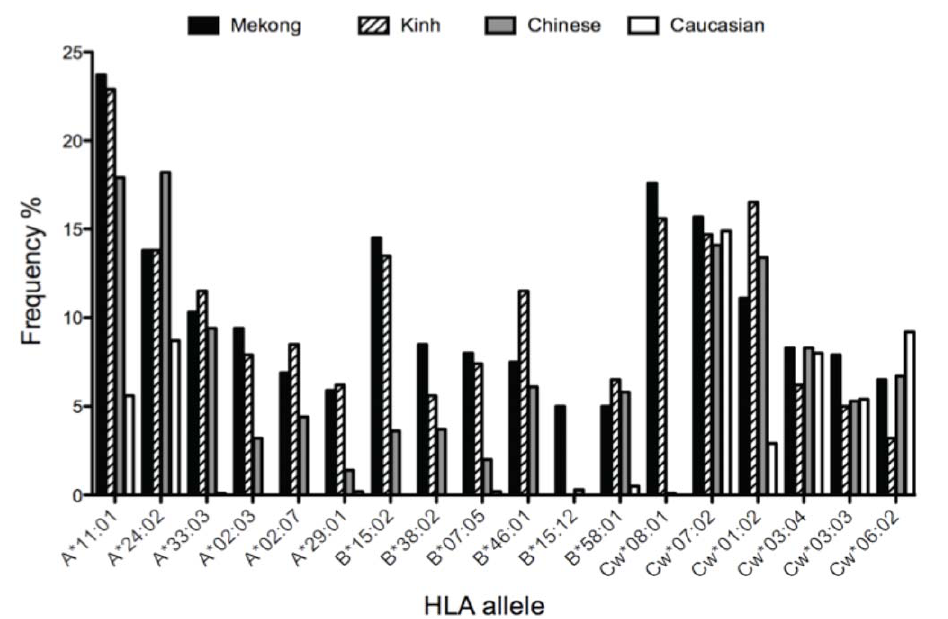
Figure 4. HLA allele frequencies in the Vietnamese Mekong Delta population (n=116) compared to Kinh Vietnamese (dashed bars), Chinese (grey bars) and European (white bars) populations. The 6 most representative HLA alleles of the Mekong Delta population are represented.